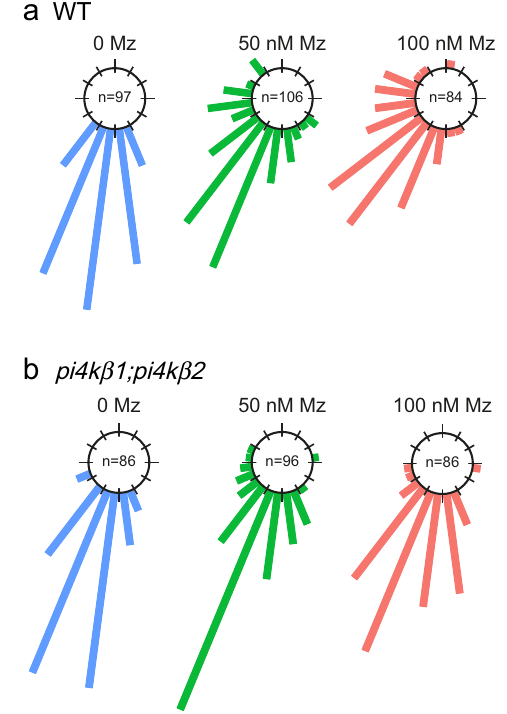
Fig. 1 Metazachlor-induced root gravitropism defects are dependent upon PI4P synthesis at TGN. Root gravitropism assay of wild-type ( a ) and pi4k β 1;pi4k β 2 double mutant ( b ), untreated (0 Mz) or treated with 50 nM metazachlor (Mz) or 100 nM Mz. After gravistimulation, root angles are calculated, distributed in 30° angle classes and plotted in circular charts where each bars correspond to the effective of roots in each classes of angles, from 0° (bottom of the chart) to 180° (top of the chart). Thus, the direction of the bars indicates the direction of growth after gravistimulation. The pi4k β 1;pi4k β 2 double mutant is more insensitive to Mz treatment than wild-type. n values are indicated in the